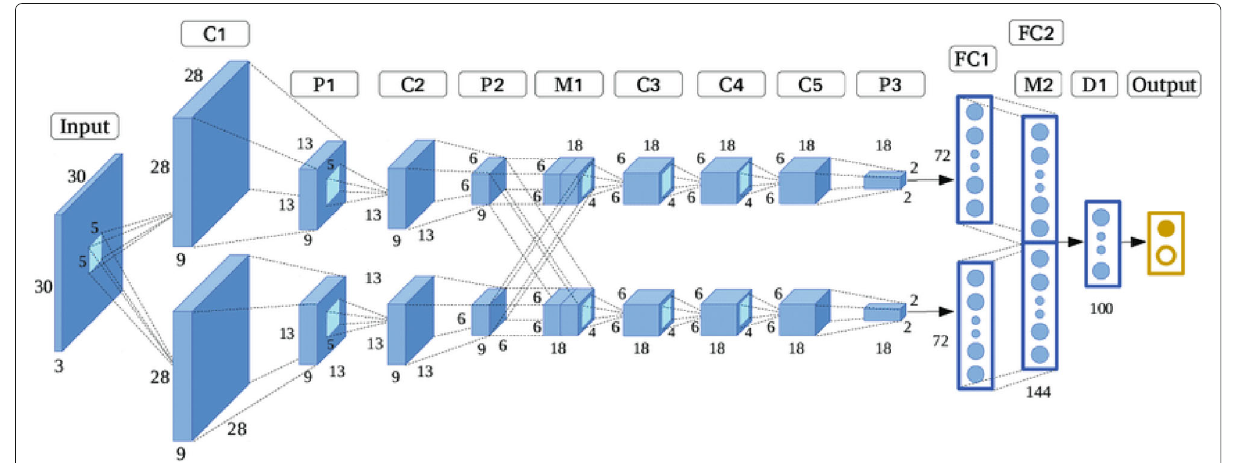
Fig. 1 The architecture of AlexNet Model